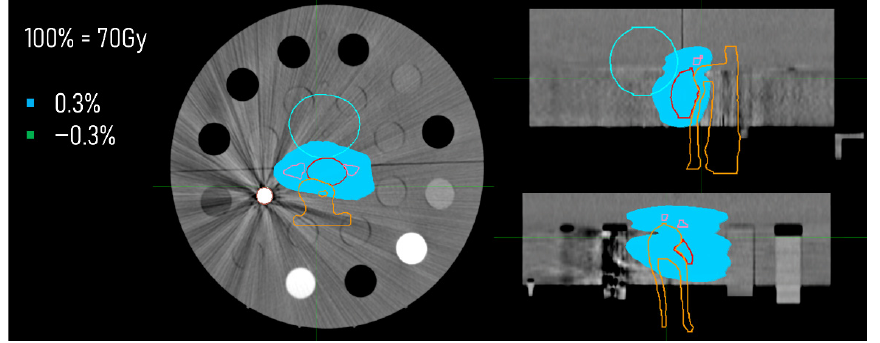
Figure 10. The absolute maximum differences in dose, expressed as percentage of the dose to the prostate (100% = 70 Gy) between the dose distributions calculated on the DD reconstruction of the CT scan of the Cheese phantom with the stainless ‐ steel insert acquired at 120 kVp using the correct calibration curve and the calibration curve related to the acquisition at 80 kVp, respectively. Blue shading corresponds to maximum differences of 0.5%. The analysis was conducted with MIM Maestro ® and the differences were reported on the DD reconstruction of the Cheese phantom acquired with the stainless ‐ steel insert at 120 kVp (axial section on the left, sagittal section at the upper right corner, and coronal section at the lower right corner).